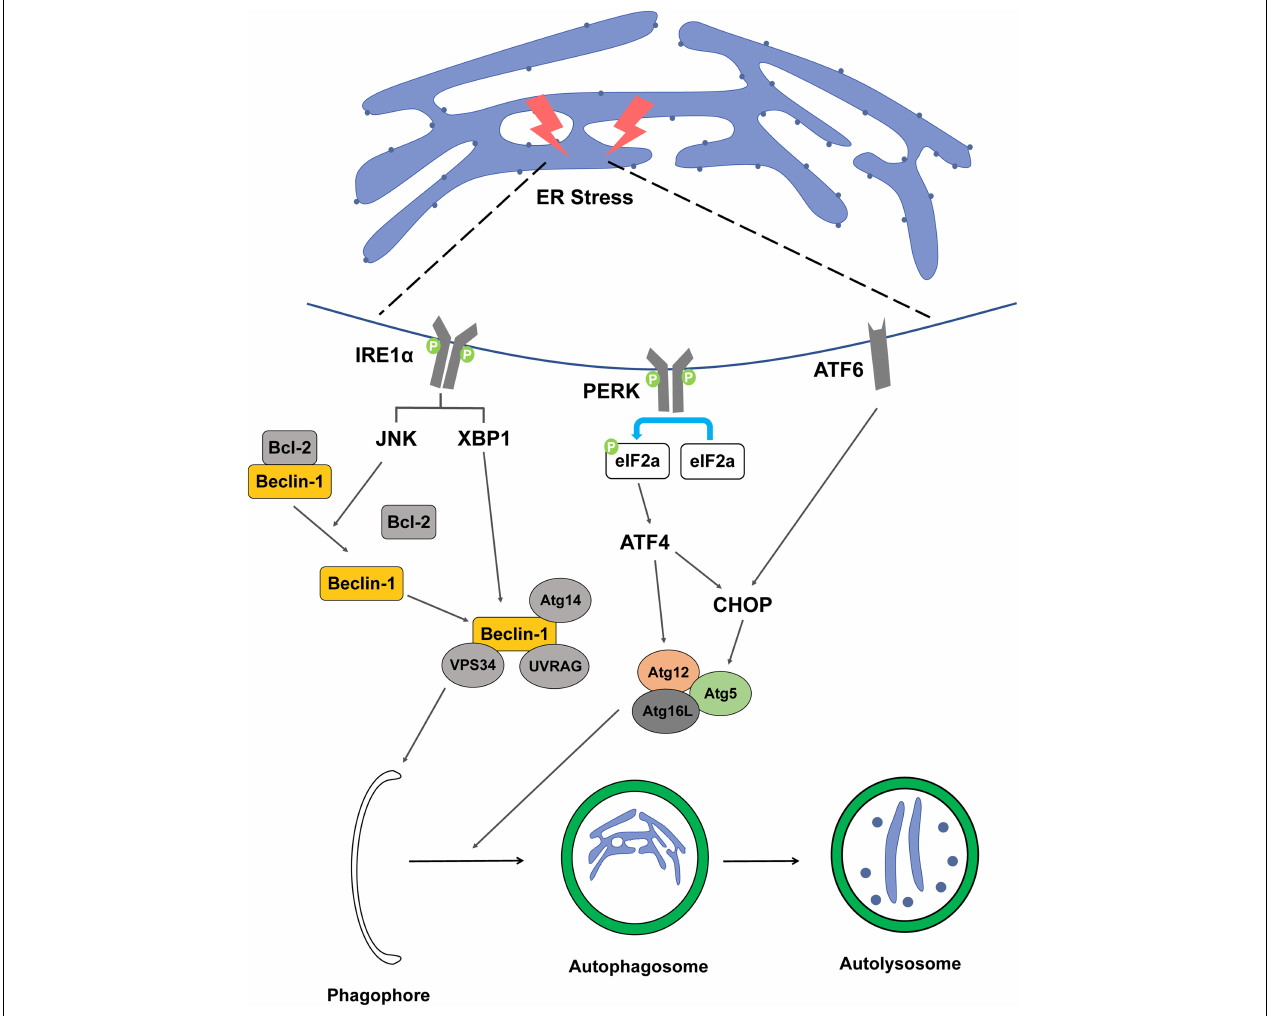
FIGURE 2 | Schematic representation between ER stress factor and ER-phagy. The figure represents a signaling pathway of ER-phagy while damaged ER is engulfed by autophagosome. When ER stress is induced by DNA damage, the IRE1a, PERK, and ATF6 signaling pathways are activated, resulting in the formation of